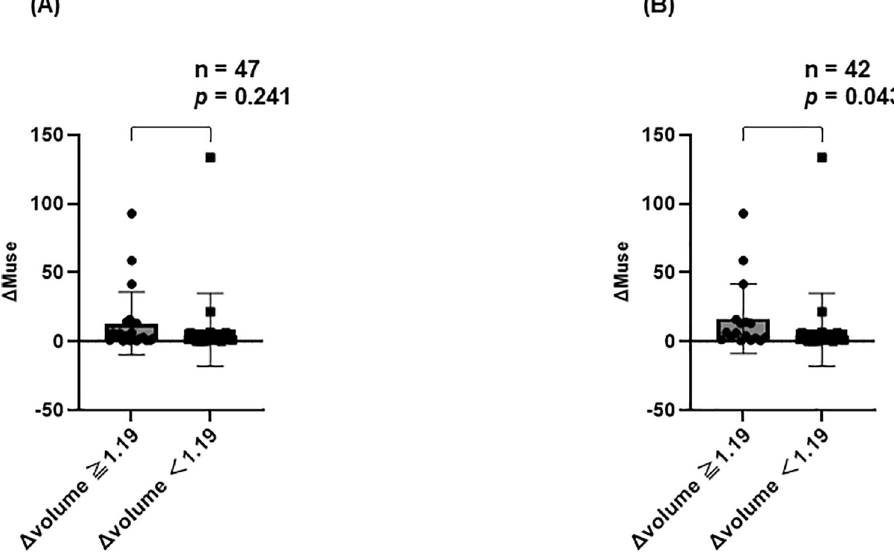
Fig 5. Liver volumetry and Muse cell numbers. A: Comparison of Δ Muse between the Δ volume � 1.19 and the Δ volume < 1.19 groups. B: Comparison of Δ Muse between the Δ volume � 1.19 and the Δ volume < 1.19 groups for the no-complication